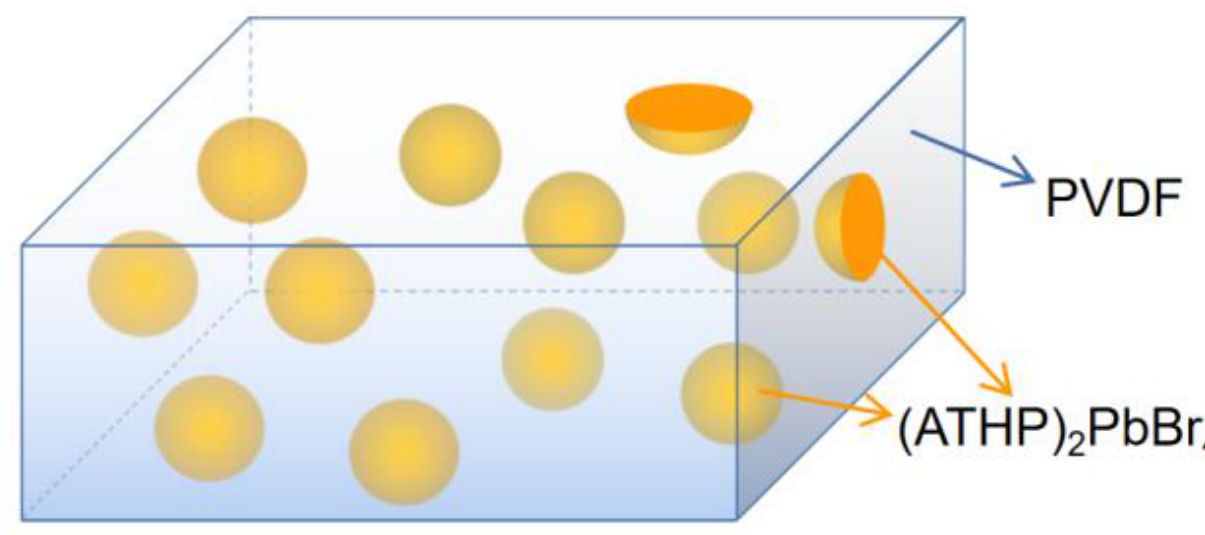
Figure 1. The 0-3 type composite piezoelectric film structure schematic.